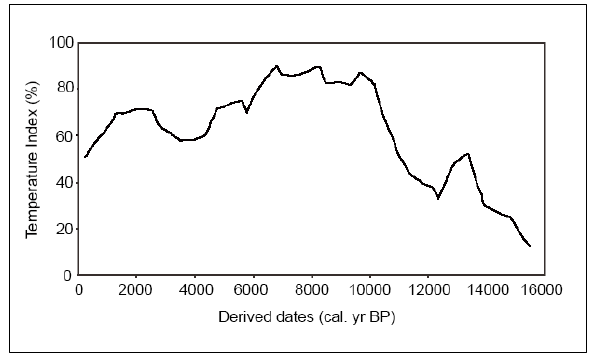
Figure 5: Temperature index for Wonderkrater within the past 16 000 years (calibrated dates) showing layers KAE, JZB and JY at KDC. Layer JZB, for which the shellfish density is the lowest, coincides with the time when temperatures might have been relatively low within the Younger Dryas. Figure modified after Thackeray and Scott’s 59 Figure 2, with